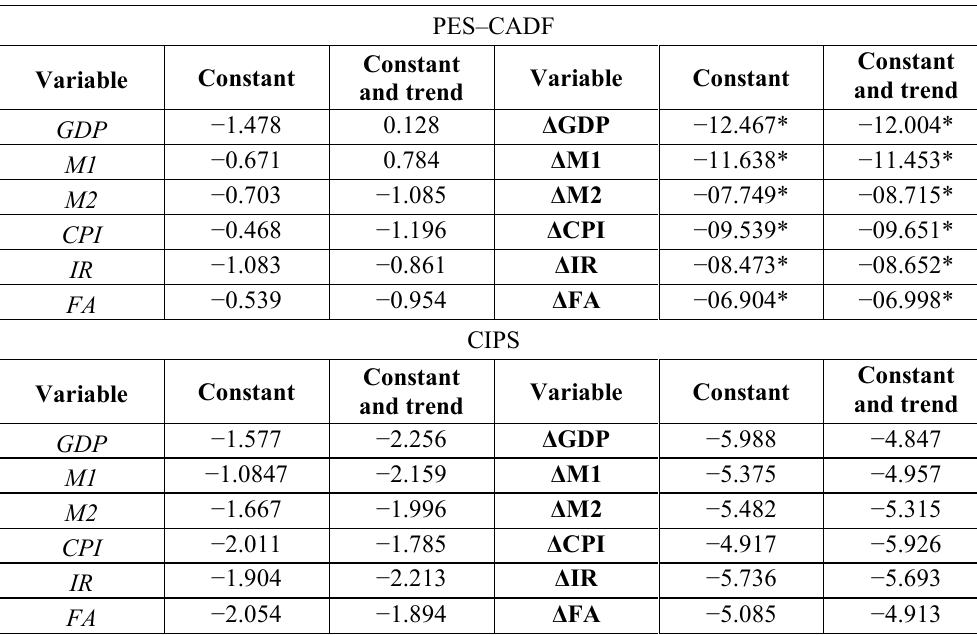
Table 2 . Unit Root Test Results (2nd Generation Tests )